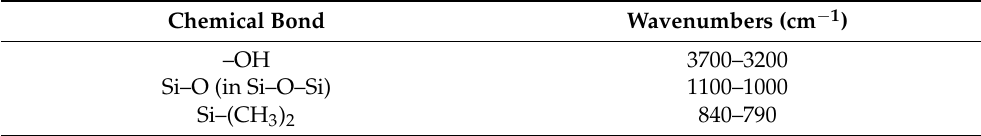
Table 2. The wavenumbers corresponding to the main chemical bond in HTV silicone